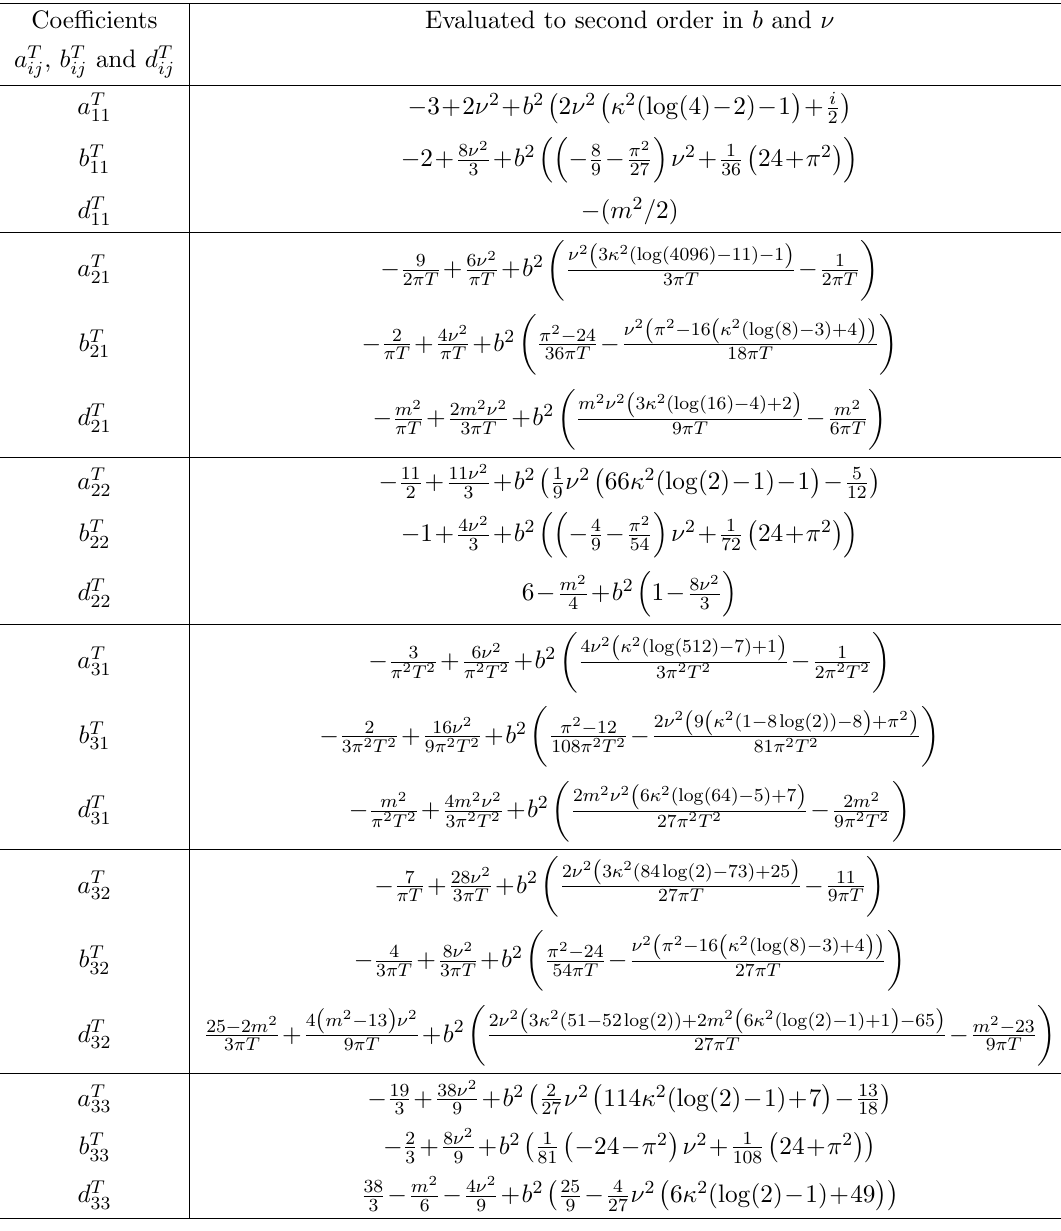
Table 3 . Transverse dynamics of scalar